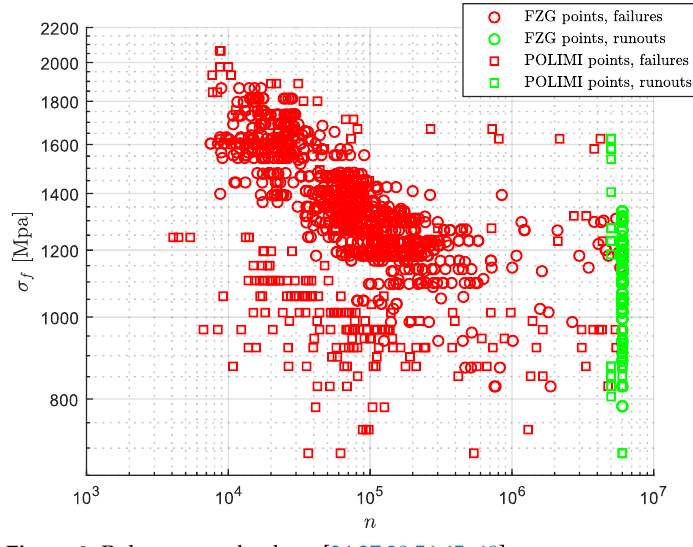
Figure 9. Pulsator test database [24,27,28,56,65–68].